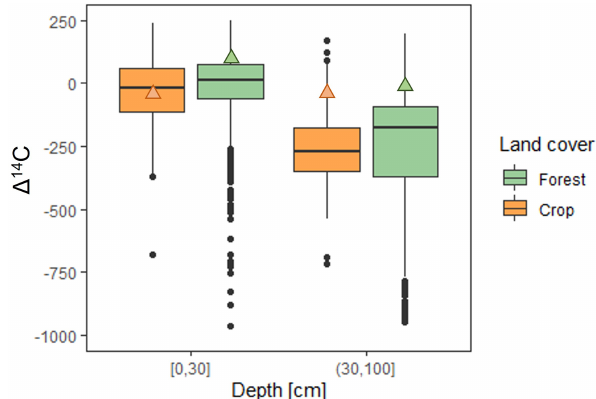
Figure 5. Comparison of the (cid:49) 14 C average at 0–30 and 30–100cm depth between this study forest soil (green triangle), this study crop soil (orange triangle), and the (cid:49) 14 C average from 185 papers, ex- tracted using R software from the International Soil Radiocarbon Database (ISRaD) database, version 1.7.8.2021-01-04 (Anon, 2020; Lawrence et al., 2020). Black dots represent outliers. Crop soil is n = 34 papers, and forest soil is n = 151 papers. The central value of the box plot is the median, the edges are the quartiles, and the ends of the whiskers represent the maximum and minimum values. In total, 50% of the observations are inside the box plot. Values outside the whiskers are represented by